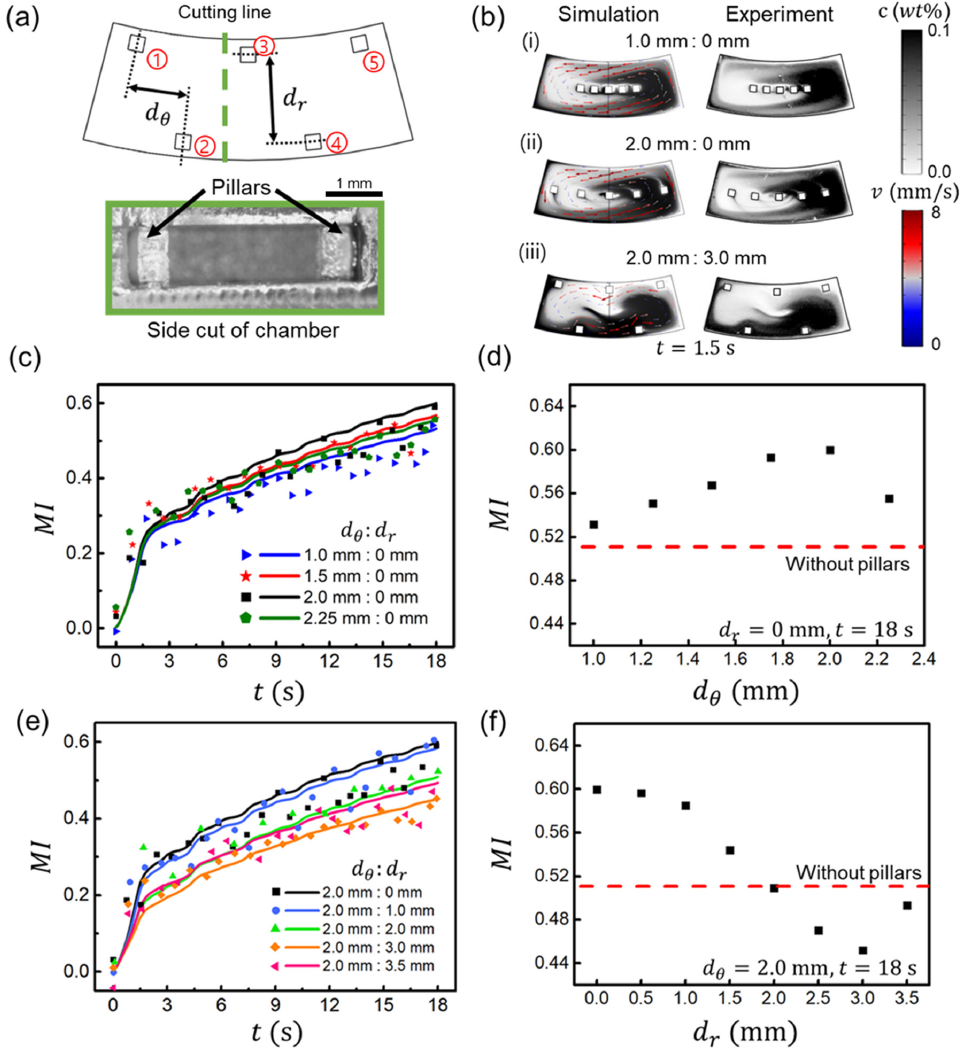
Figure 5. ( a ) Schematic of a rotating mixing chamber with five square pillars of 0.5 ( w ) × 0.5 ( w ) × 1 ( h ) mm 3 . Here, d θ and d r are the distances between the pillars in angular and radial directions, respectively. The five pillars from 1 to 5 were fabricated using a 3D printer, as seen in the